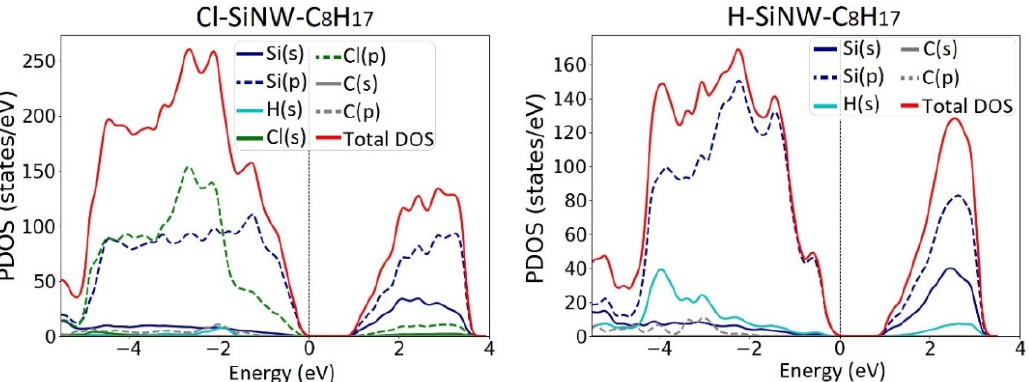
Figure 9. Projected electron density of states (PDOS) of Cl-SiNWS-C 8 H 17 ( left ) and H-SiNWS-C 8 H 17 ( right ) systems.